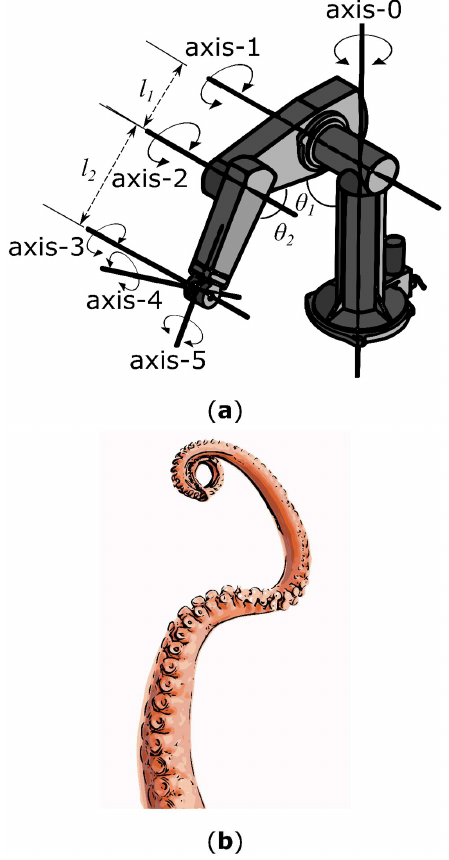
Figure 3. An illustration of a hard-bodied system and a soft-bodied system that could be employed to grasp and manipulate objects. ( a ) A simple rigid bodied system (Programmable Universal Machine for Assembly (PUMA) robot); ( b ) a complex soft-bodied system. The functionality of the PUMA robot can be broken down into (1) grasping an object, and (2) moving in free space. These functions can be further broken down until the system is described fully. The physical hierarchy of the PUMA robot (e.g., electric direct current (DC) servo motors, four-way pneumatic solenoid grippers, nuts and bolts, etc.) has little or no relevance to soft-bodied systems [49], which have more characteristics in common with an octopus arm. Both the PUMA robot and the octopus arm, however, have the same behavior— to grasp and manipulate an object—but each uses a completely different physical implementation.